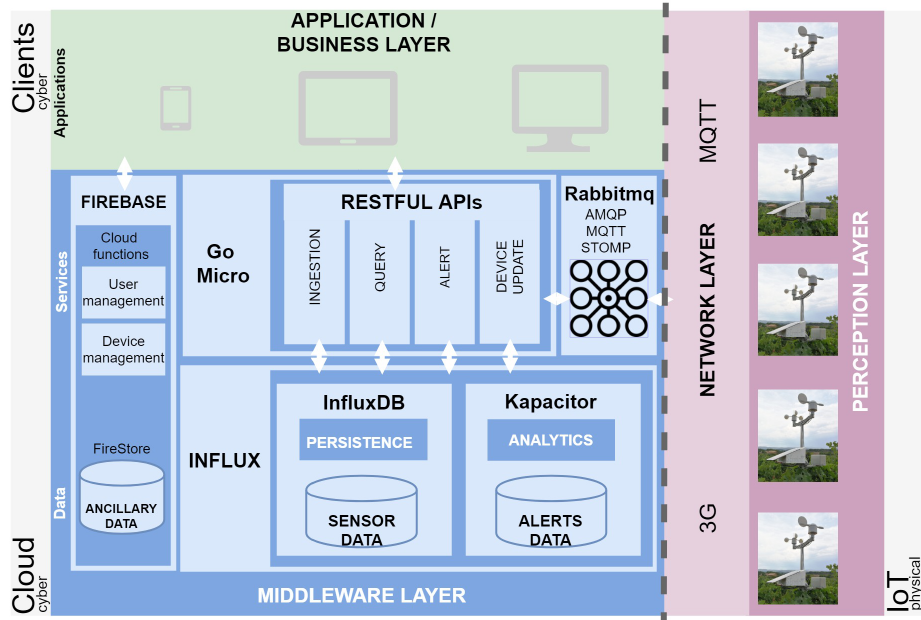
Figure 12. A general overview of the full IoT environment.